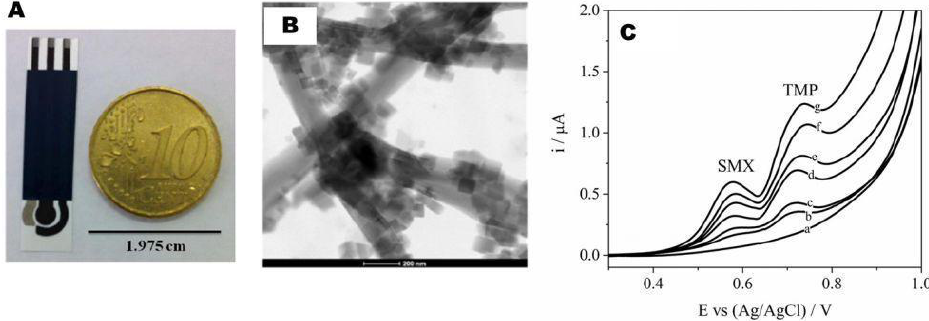
Figure 3. ( A ) Image of the screen-printed sensor including a carbon working electrode modified with MWCNT-PBNC (in the center), a Ag/AgCl reference (left) and a carbon counter electrode (right side). ( B ) Transmission electron microscopy (TEM) image of MWCNT-PBNC composite used for working electrode modification. ( C ) DPV of MWCNT-PBNC-SPE in 0.04 mol L −1 Britton Robinson buffer pH 7.0 in equimolar mixtures of SMX and TMP with increasing concentrations: (a) 0 µmol L −1 ; (b) 1 µmol L −1 ;